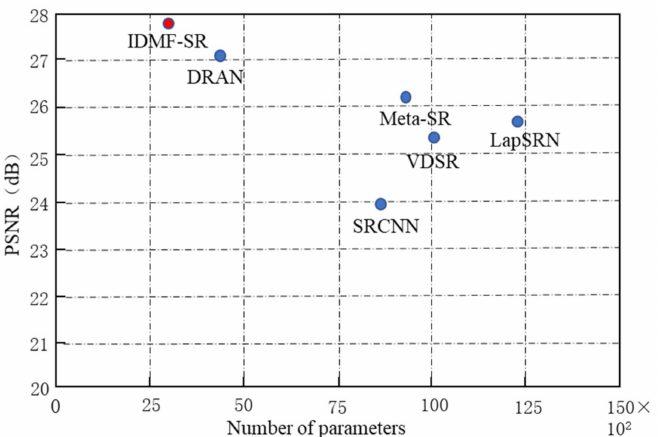
Figure 10. Multiple model PSNR value and parameter quantity relation diagram.